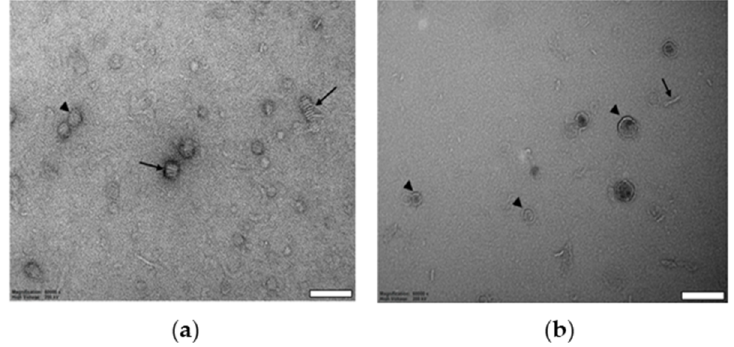
Figure 2. EM micrographs of DIBMA/DMPC nanoparticles. Negative-stain TEM ( a ) and cryo-TEM image ( b ) at 1:1 DIBMA/lipid weight ratio. The arrowheads and arrows indicate particles observed face-on and edge-on, respectively. Scale bar 100 nm.